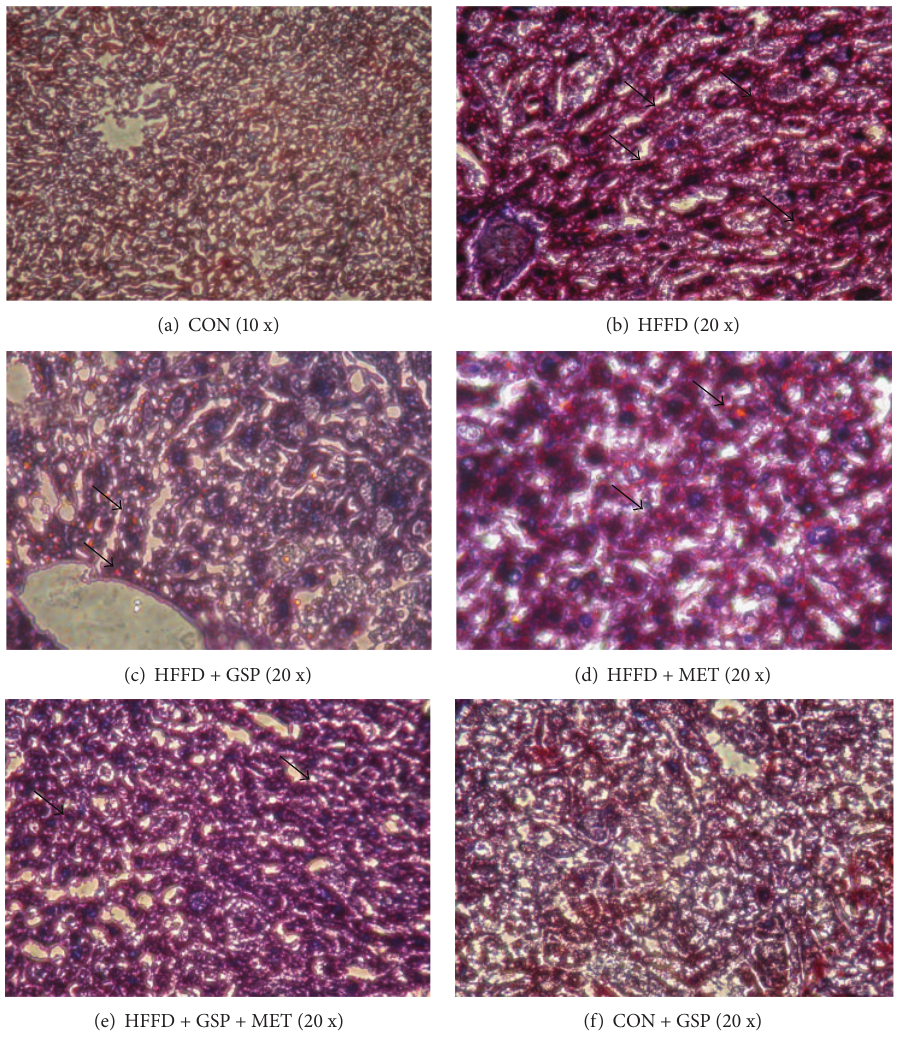
Figure 9: Histology of liver stained using Oil Red O. Sections from liver tissue of CON (a) and CON + GSP (f) show liver sections with normal architecture. HFFD-fed rats show severe steatosis and ballooning degeneration of hepatocytes (b). GSP administration to HFFD-fed rats show, minimal amount of steatosis (c), whereas MET administration to HFFD-fed rats shows moderate steatosis (d). HFFD + GSP + MET show hepatocytes with occasional areas of steatosis (e). (Black arrows indicate Oil Red stain